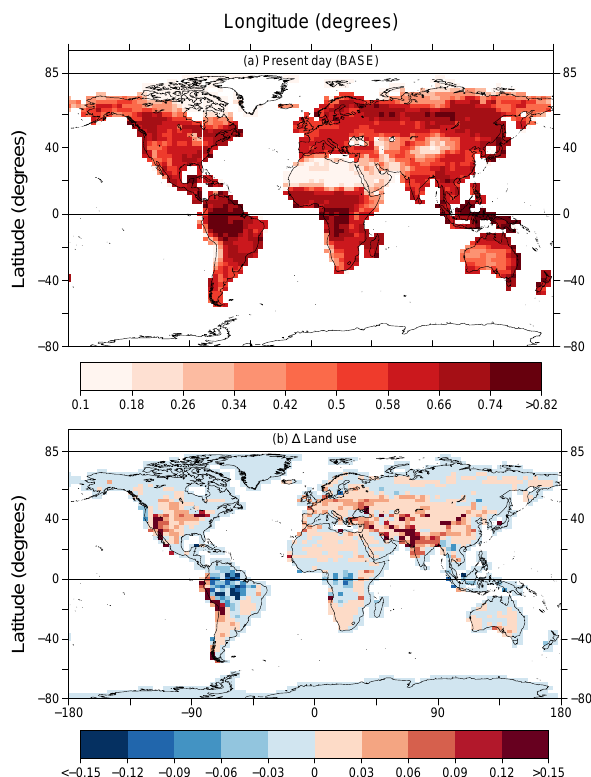
Fig. 7. O 3 deposition velocity over land (cms − 1 ) for (a) present- O deposition velocity over land (cm s − 1 ) for (a) present day (i.e. without land use Fig. 7. 3 day (i.e. without land use change), and (b) with future land use change), and (b) with future land use change. Negative values indicate a decrease in the de- change. Negative values indicate a decrease in the deposition ve- position velocity due to land use change. locity due to land use deposition velocity (cm s -1 ) for (a) present day (i.e. without land use change), and Fig. 7. O 3 40 (b) with future land use change. Negative values indicate a decrease in the deposition velocity due to land use change. 36